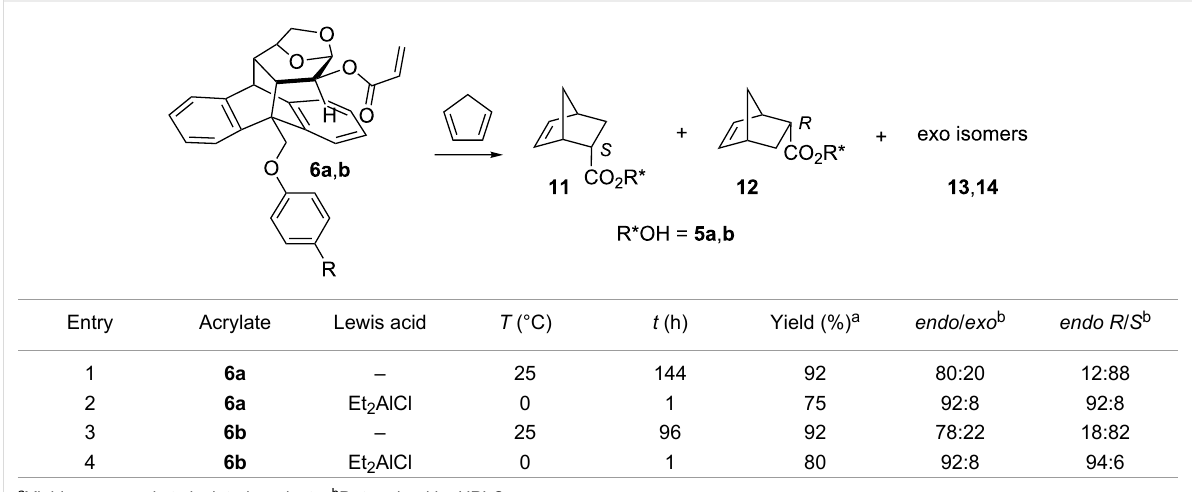
Table 2: Thermal and Lewis acid promoted Diels–Alder reactions of 6a , b and